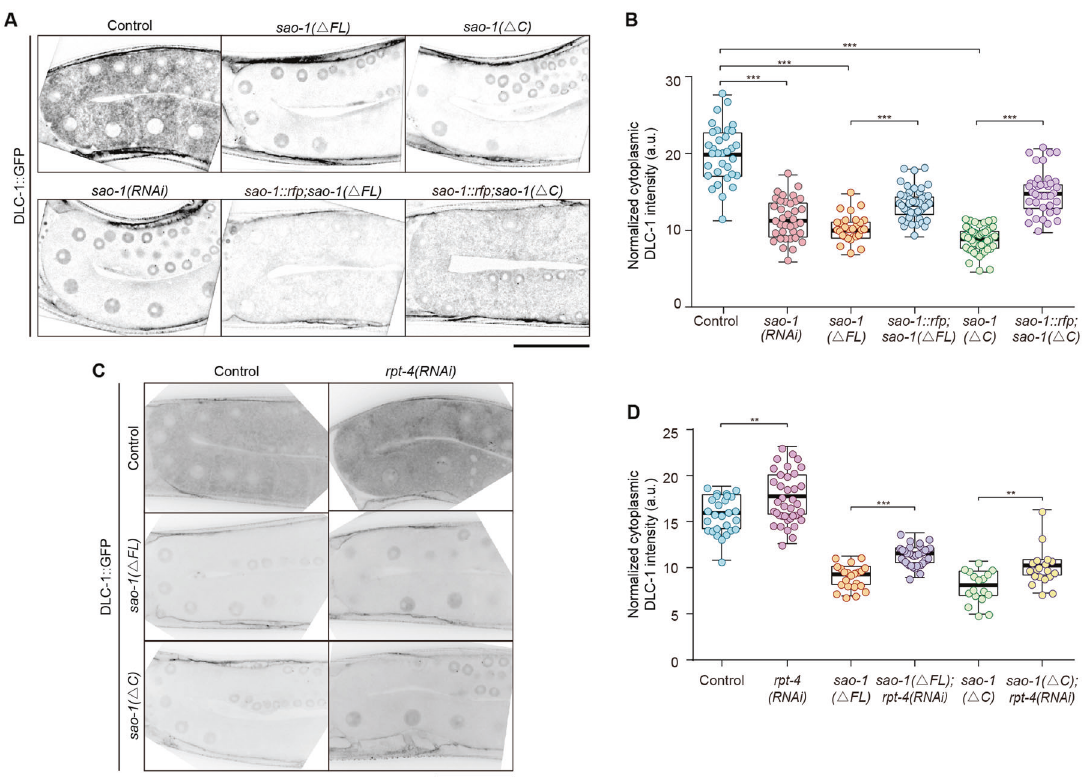
Fig. 3 SAO-1 regulates DLC-1 in the cytoplasm of the C. elegans germline. A Representative confocal images of DLC-1::GFP in control, sao- 1(RNAi) , sao-1( Δ FL) , sao-1( Δ C), Ex[sao-1::rfp] ; sao-1( Δ FL) and Ex[sao-1::rfp] ; sao-1( Δ C) . The schematic representation of sao-1( Δ C) please refer to Fig. 4C. B Quanti fi cation of normalized DLC-1::GFP intensity in A . C Representative confocal images of DLC-1::GFP in control, rpt-4 (RNAi), sao- 1( Δ FL) , sao-1( Δ FL);rpt-4(RNAi) , sao-1( Δ C) and sao-1( Δ C);rpt-4(RNAi) . D Quanti fi cation of cytoplasmic DLC-1::GFP intensity in C . Each dot in the chart represents a single worm. Data were analyzed by two-tailed Student ’ s t test; Error bars, ±SEM; **p < 0.01, ***p < 0.001. a.u. arbitrary unit. Scale bar, 50 μ